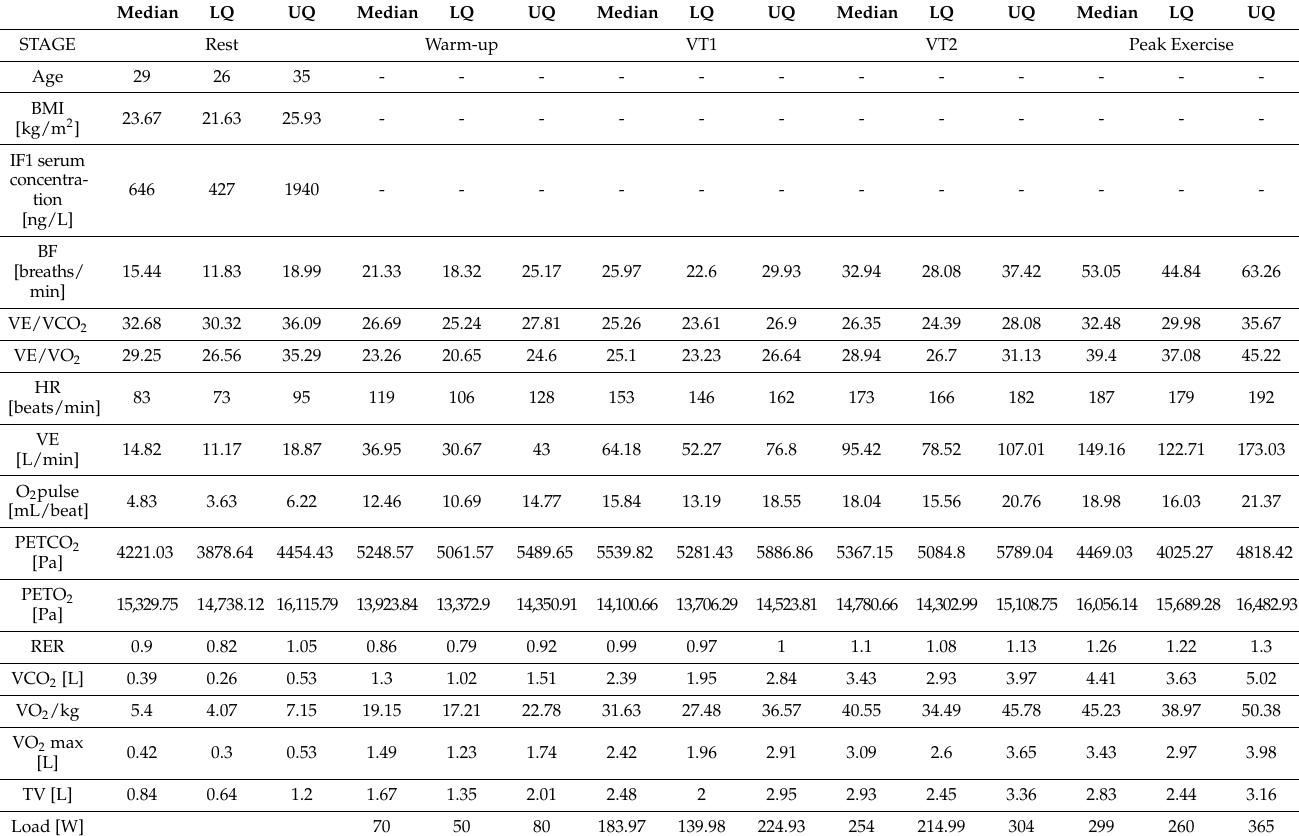
Table 1. Summary of CPET parameters measured at rest, warm-up, VT1, VT2, and peak